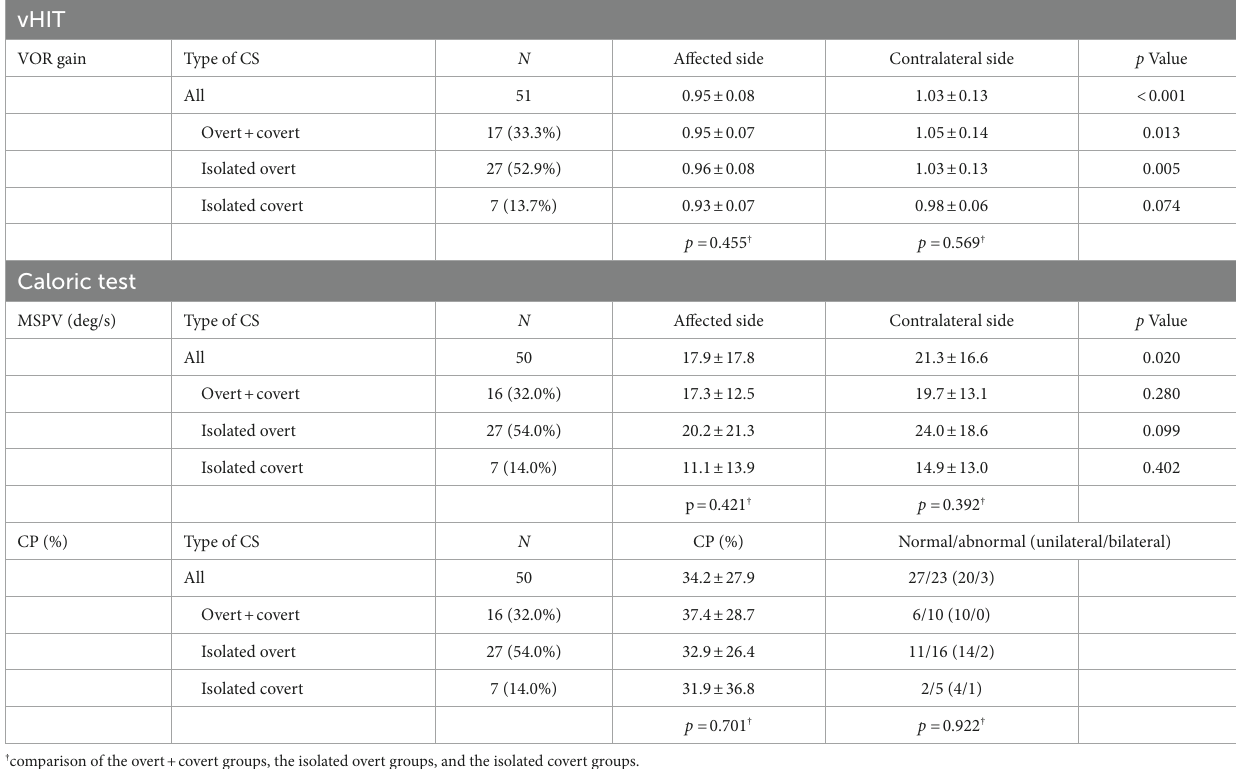
TABLE 2 Head impulse test (vHIT) and caloric test in patients who showed CS with normal VOR gain. vHIT